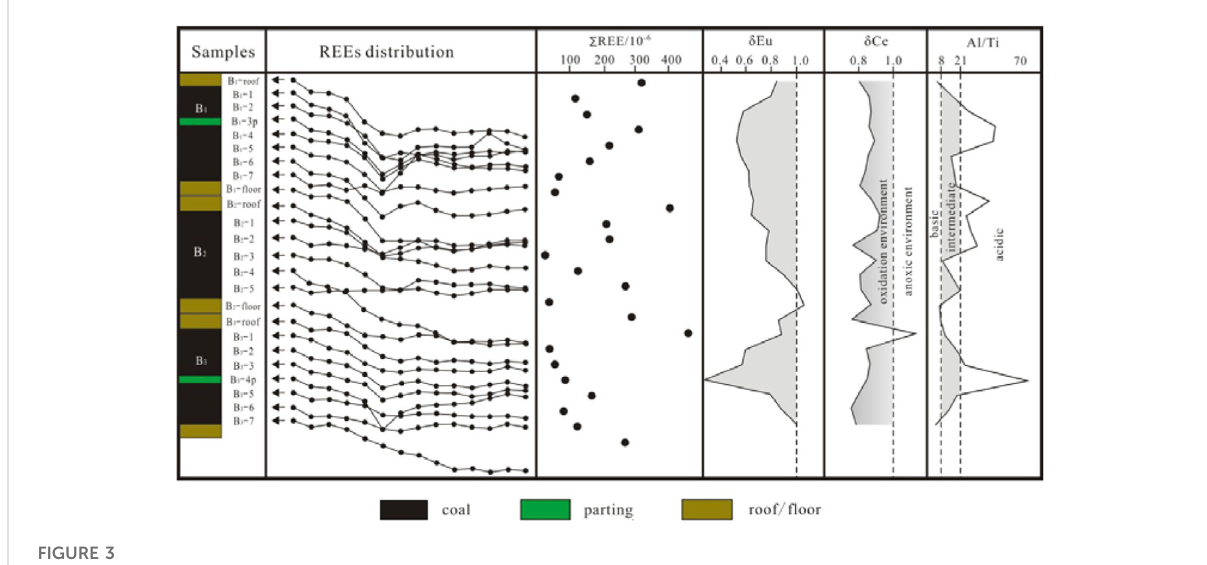
FIGURE 3 Stratigraphic distribution of patterns of (cid:1) REE, δ Eu, δ Ce and Zr/Hf in all coal samples from Yantang Mine, Xuanwei, Yunnan.